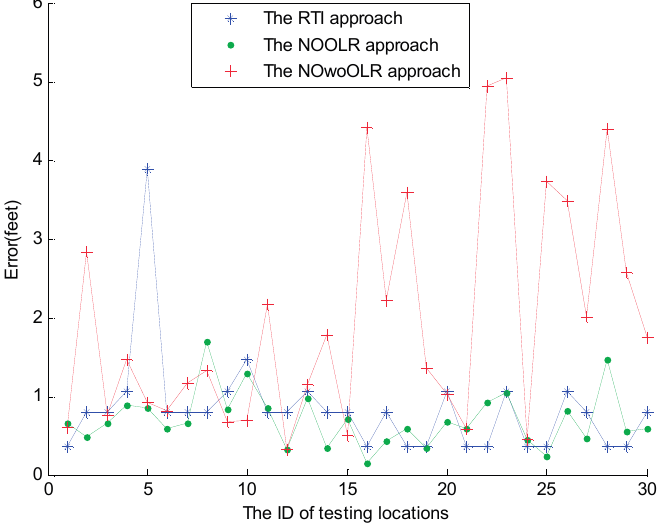
Figure 9. Performance comparison of NOOLR, NOwoOLR, and